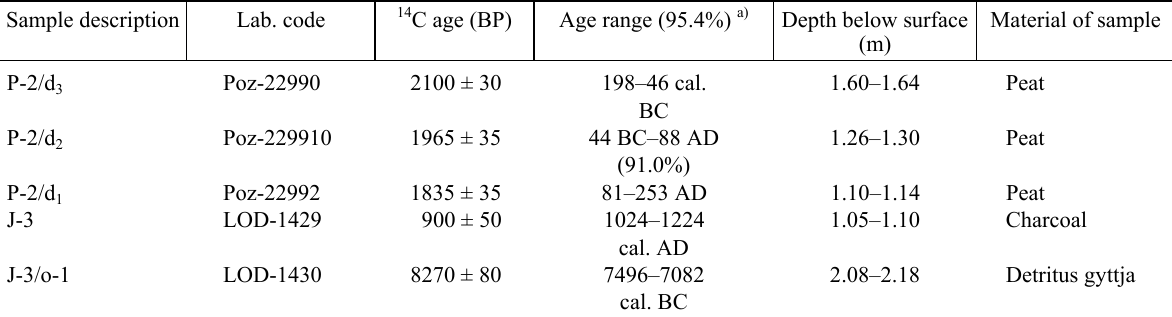
Table 2. Sample description with conventional and calibrated ages of the samples Sample